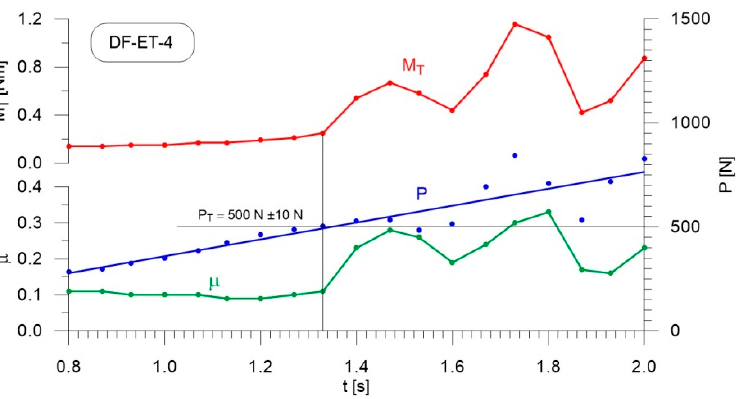
Figure 6. Courses of the load, P, the friction torque, M T , and the friction coefficient, µ for diesel–ethanol blend with a 4% ethanol volume fraction.